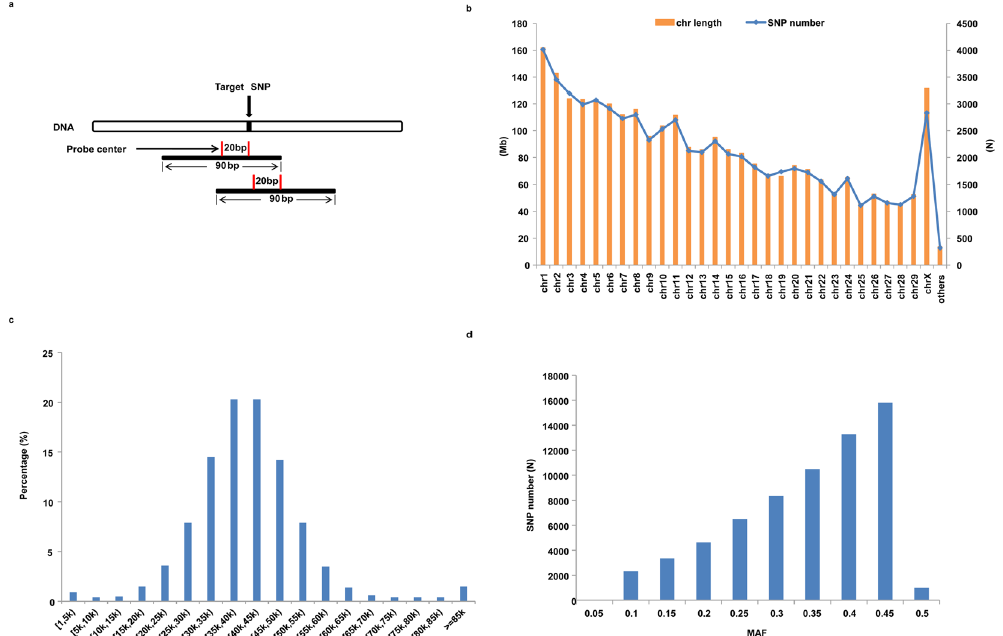
Figure 3. The characterization of final SNPs selected for designing the 66 K SNP chip. ( a ) The schematic graph of probe design. The distance between the center of probe and the target SNP is shown. ( b ) The number of SNPs corresponds to the lengths of scaffolds/chromosomes in the goat genome. ( c ) The frequency distribution of the spaces between neighboring SNPs. ( d ) The frequency distribution of the MAFs of the selected